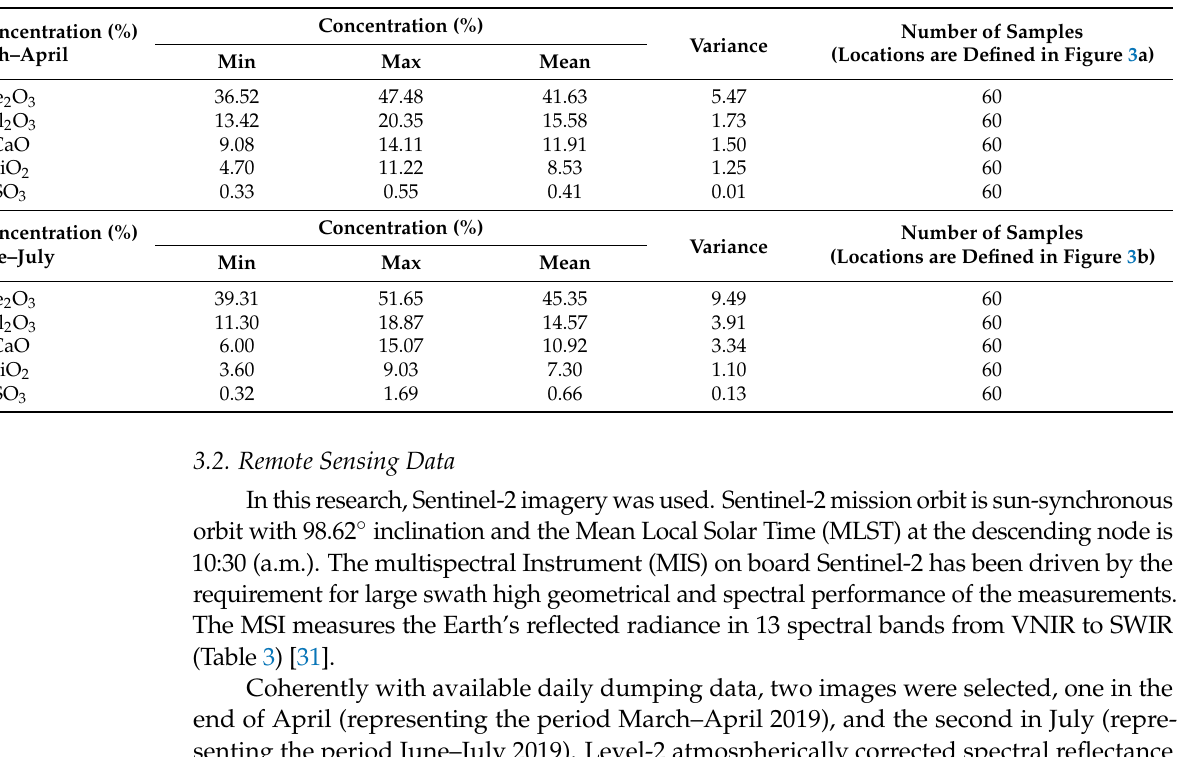
Figure 3. Daily dumping data (red points) showing the area of accumulated materials within BR for March–April ( a ) and June–July ( b ) used for mapping Al 2 O 3 concentration. Table 2. Statistical parameters of daily dumping